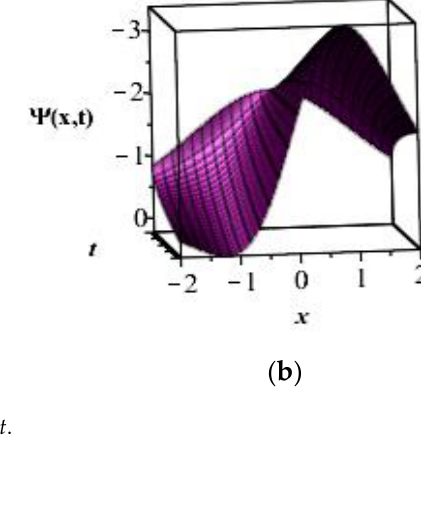
Figure 1. The solution plots of ψ ( x , t ) at ( a ) α = 0.5 ( b ) α = 0.25 ( c ) α = 0.75 ( d ) α = 1 with c = 0.005 and k = 0.5 for Equation (25).